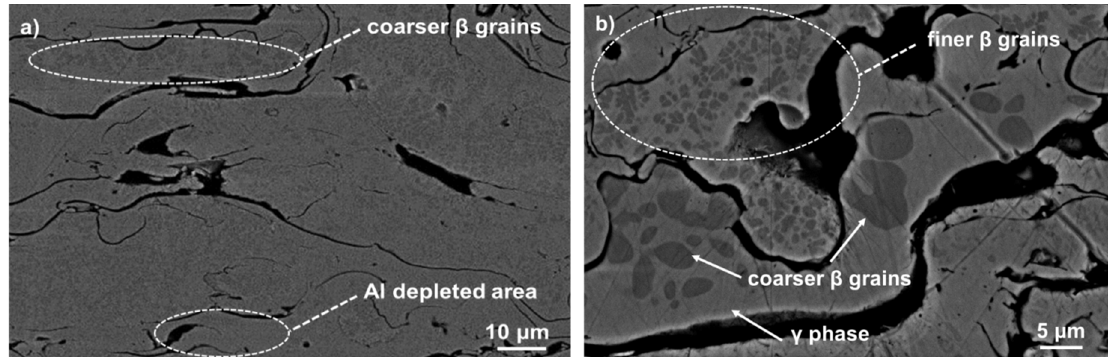
Figure 3. ( a ) Cross sectional SEM microstructure showing two-phase microstructure and typical defects of as-sprayed NiCoCrAlYRe coating; and ( b ) SEM micrograph showing coarser and finer β precipitates dispersed in the γ